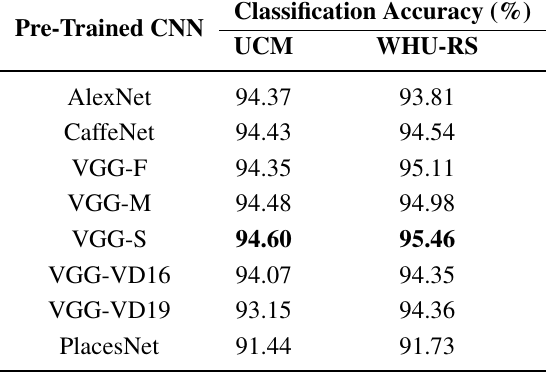
Table 2. Performance Comparison of CNN Features (from the second layer) of Various Pre-trained CNN Models.